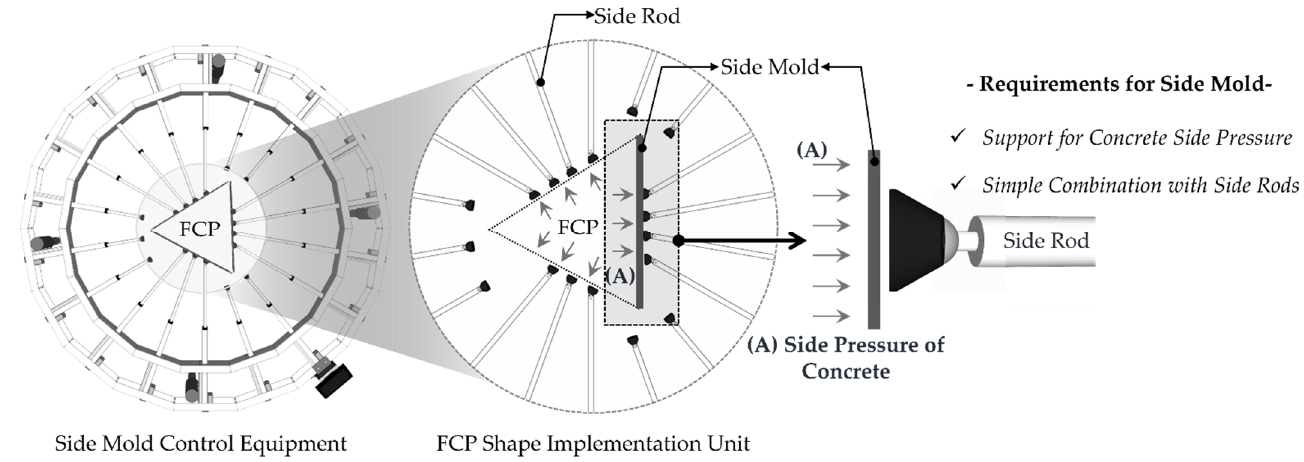
Figure 3. Requirements for variable side mold materials.